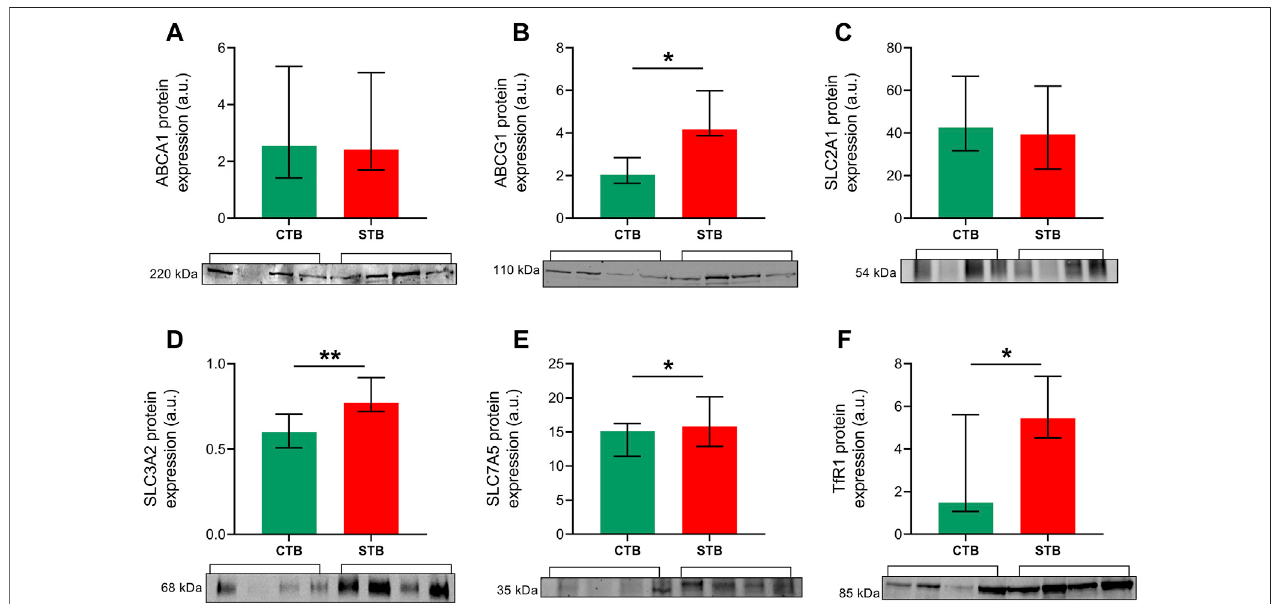
FIGURE 4 | Expression of selected proteins of interest in primary trophoblast cells. Western blot analysis was carried out to evaluate the protein expression of cholesterol ef fl ux transporters ABCA1 (A) and ABCG1 (B) , glucose uptake transporter SLC2A1 (C) , 4F2 heavy chain SLC3A2 (D) and amino acid transporter SLC7A5 (E) , and iron uptake receptor TfR1 (F) . Protein expression was normalized to the total protein, as visualized by Ponceau S staining. Data are shown as median with IQR; n = 4 for each stage. Asterisks indicate signi fi cance according to nonparametric t -test (Mann-Whitney test): * p ≤ 0.05, ** p ≤ 0.01.